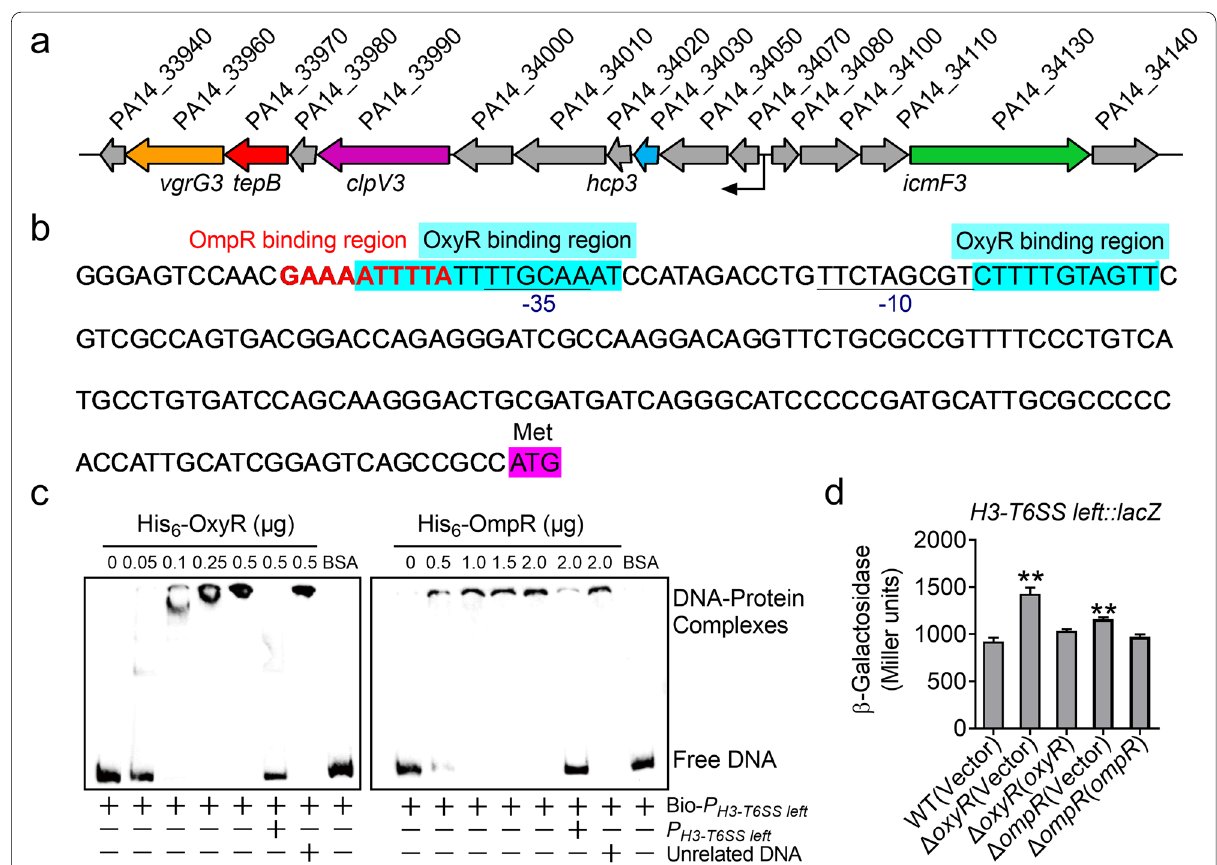
Fig. 1 H3-T6SS is negatively regulated by OxyR and OmpR in P. aeruginosa PA14. a Gene organization of H3-T6SS gene cluster in P. aeruginosa PA14. b The sequence of the H3-T6SS-left promoter. The cyan part is the OxyR binding site predicted by software; the bold red letters is the predicted OmpR binding site; the ATG start codon of the first ORF of the H3-T6SS operon is marked in purple, and the promoter are underlined. c EMSA experiments verify the binding of His 6 -OxyR and OmpR to the H3-T6SS promoter. P H3-T6SS left is the unlabeled H3-T6SS promoter probe, Bio- P H3-T6SS left is labeled by biotin, and Unrelated DNA is the unrelated DNA fragment in same length. d β-galactosidase analyses of H3-T6SS promoter activities by using the transcriptional P H3-T6SS left ::lacZ chromosomal fusion reporter expressed in the P. aeruginosa PA14 strains grown to stationary phase in TSB medium. Data represent the mean three technical replicates. ** P <